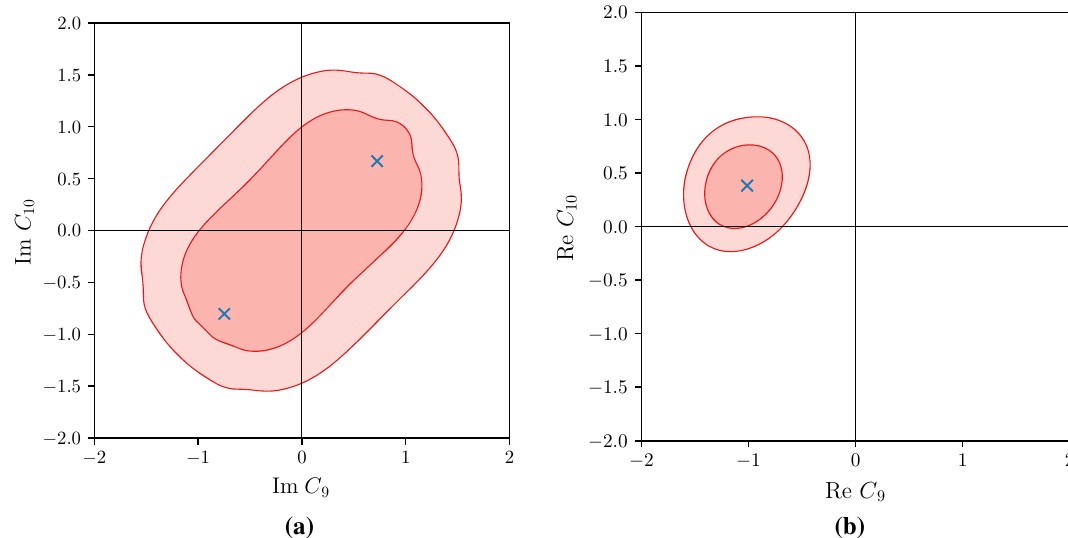
Fig. 2 Best fit and 1 σ and 2 σ contours to semi-leptonic B -decays observables, R K , R K ∗ 0 , P (cid:2)